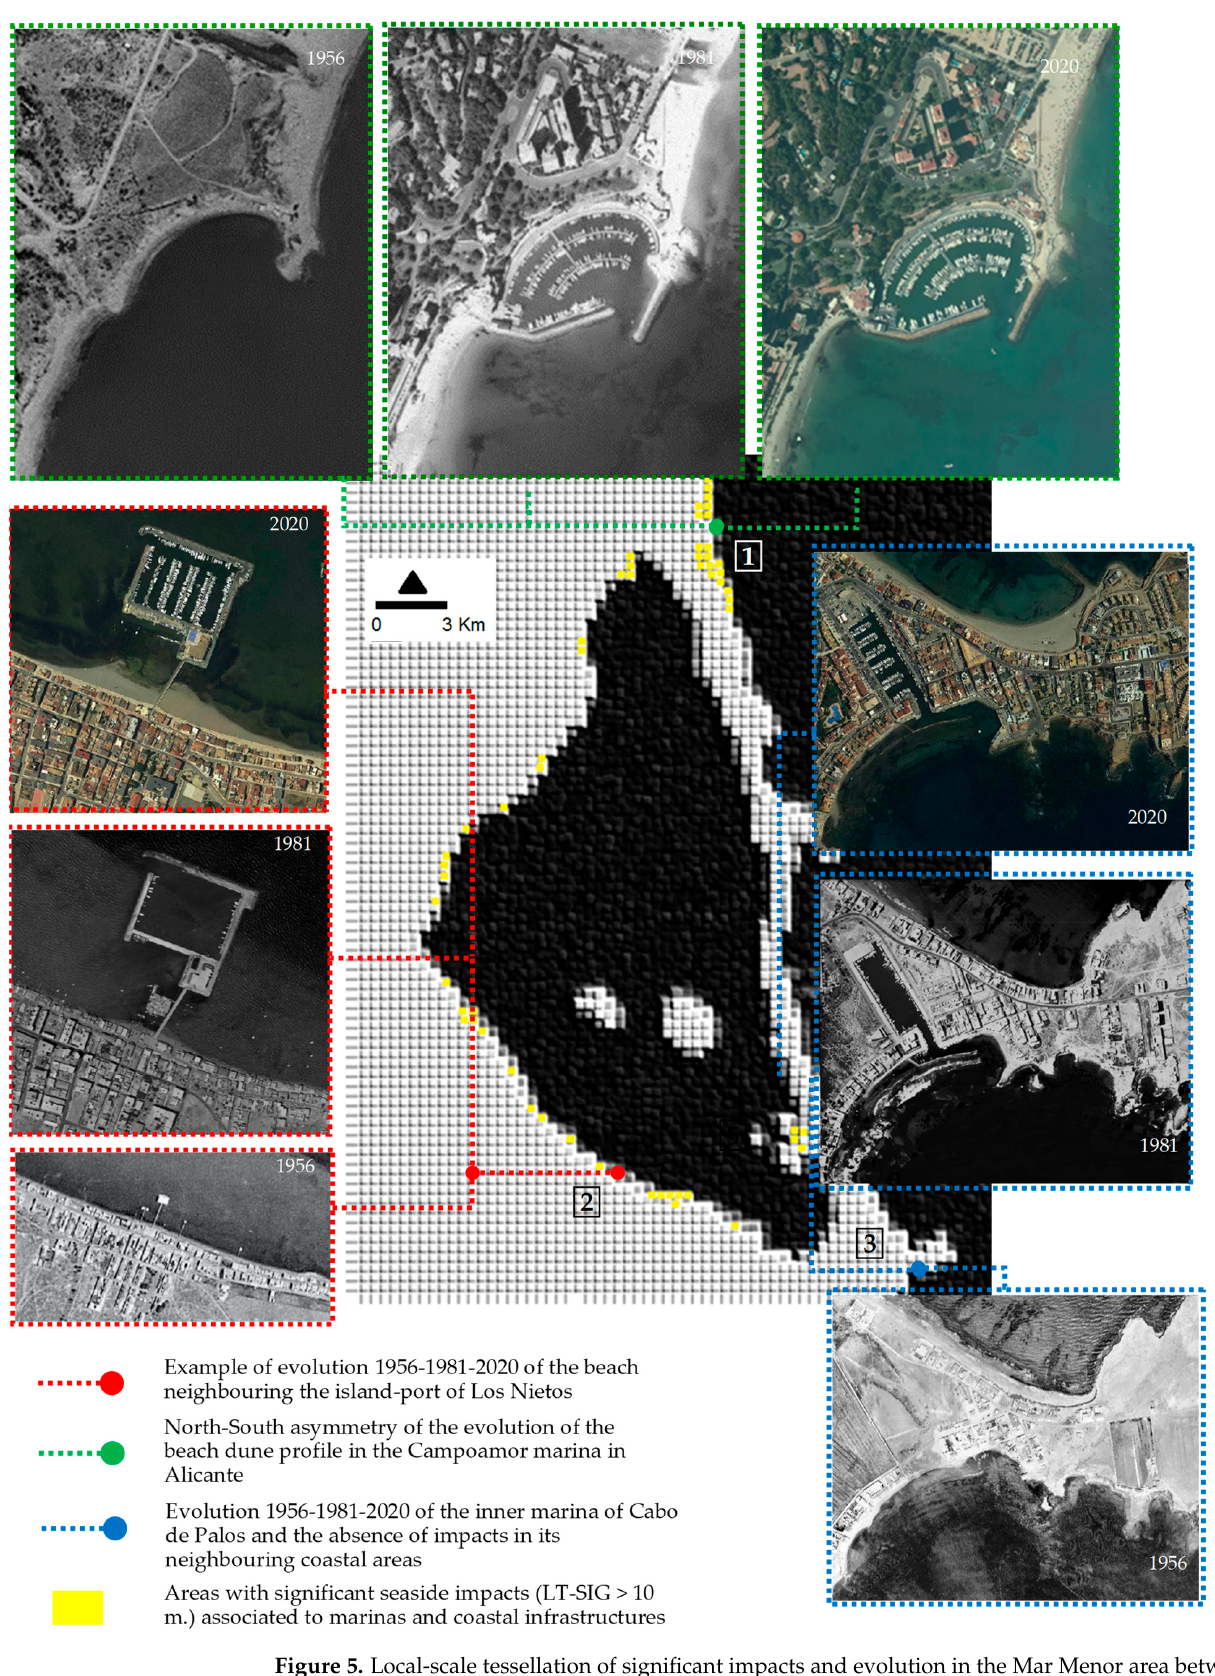
Figure 5. Local-scale tessellation of significant impacts and evolution in the Mar Menor area between 1956 and 2020: (1) Campoamor marina, (2) Los Nietos marina and (3) Cabo de Palos marina.